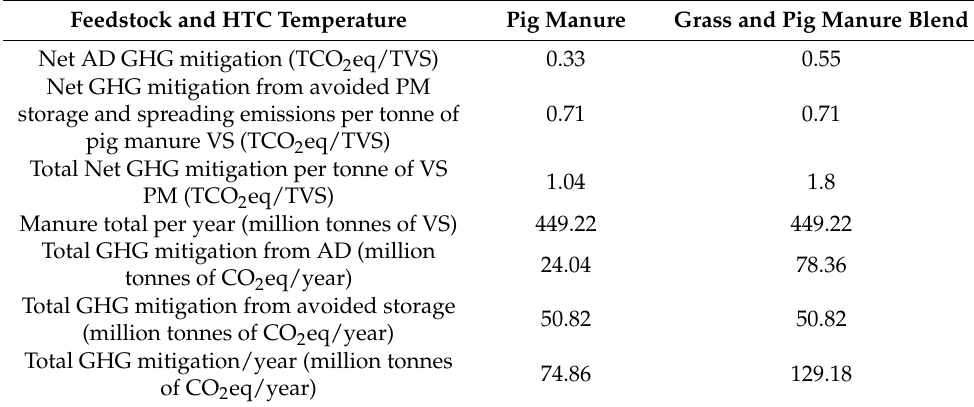
Table 7. Chinese GHG mitigation from AD of PM and PM-grass blend.